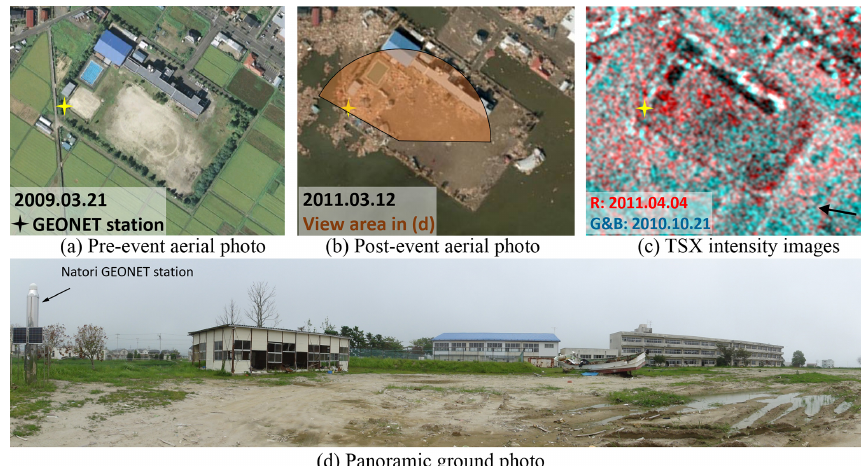
Figure 4. (a–b) Pre- and post-event aerial photographs taken by the Geospatial Information Authority of Japan (GSI) around the Natori GEONET station. (c) A colour composite of the pre- and post-event TerraSAR-X (TSX) intensity images taken in path C at the same location. (d) A handheld panoramic ground photo of the orange area in (b) that was taken during the field survey on 4 August